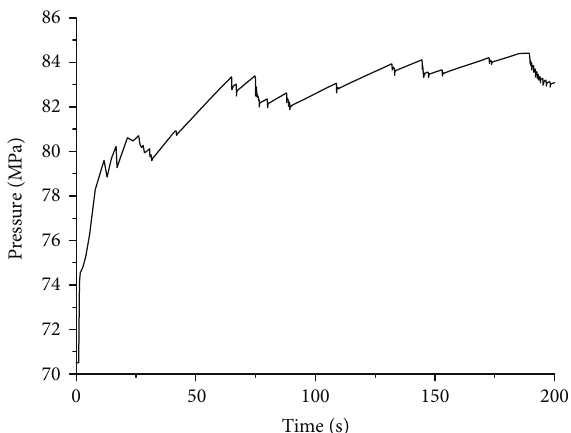
Figure 24: Pressure curve at the NF approaching angle of 45 ° and stress anisotropy coe ffi cient of